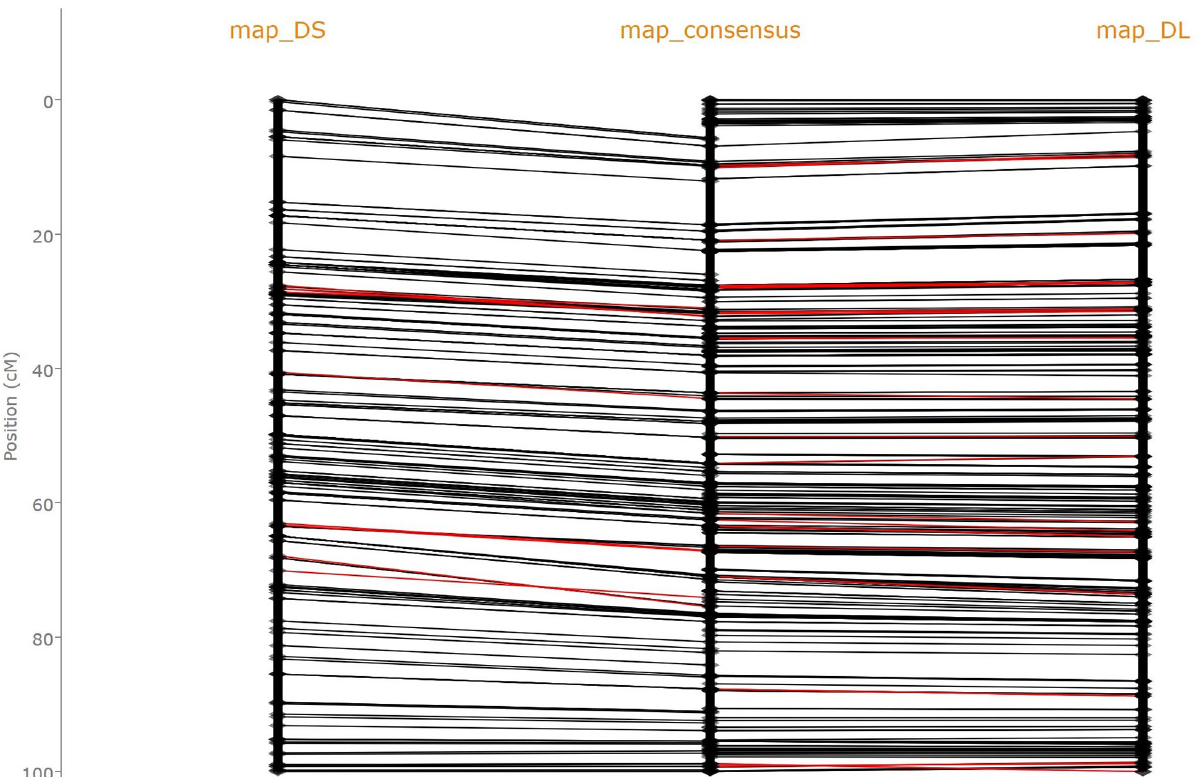
Fig 5. Screenshot of a comparison of three genetic maps of the 3A chromosome of durum wheat displayed by the Genetic Map Comparator . The map_DS (right) and map_DL (left) were obtained using different durum wheat progenitors; map_consensus (middle) is the consensus of those two maps as proposed by [32]. For this comparison, two LCS have been computed: the LCS of map_DS and map_consensus and the LCS of map_DL and map_consensus. Markers present in two adjacent maps are then connected by black, or red, edges depending on whether they are, or not, part of their